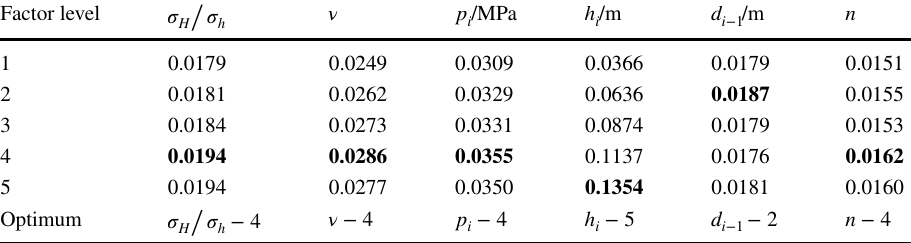
Table 4 Weight calculation results of each level in each factor under comprehensive evaluation